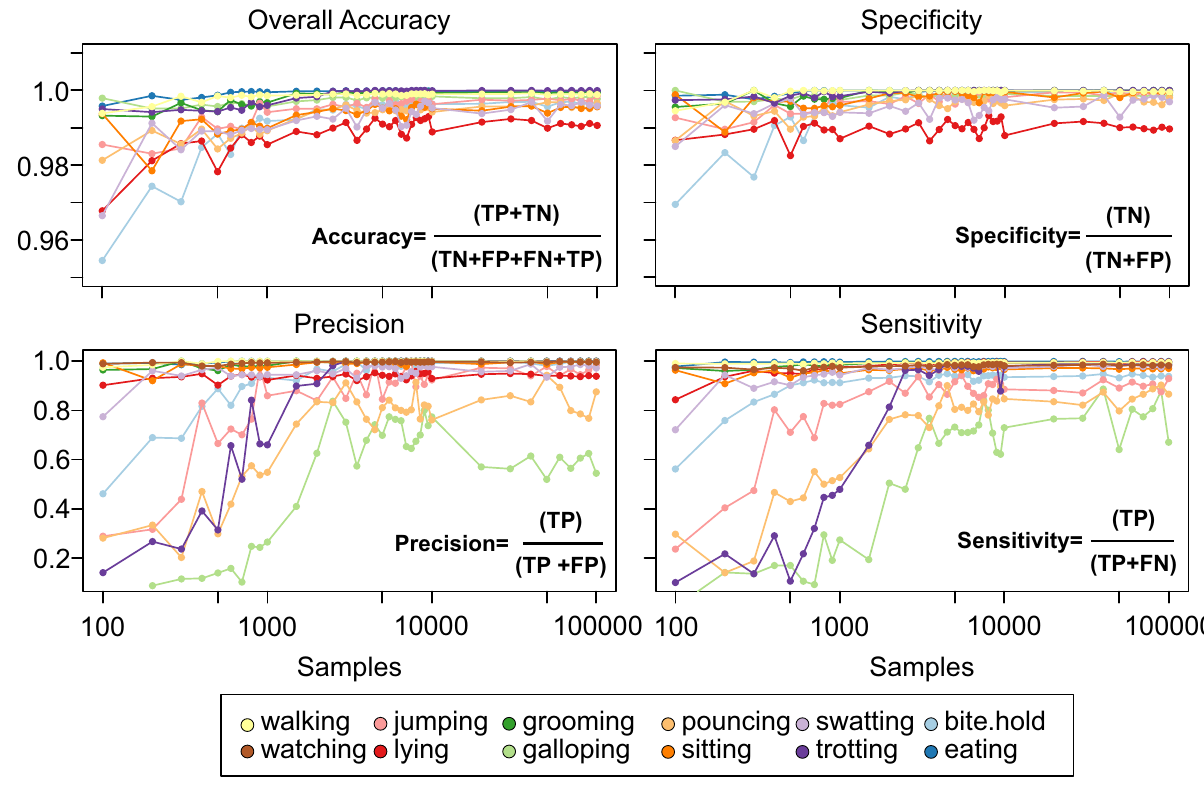
Figure 2. Predictability of the SOM procedure across four behaviour specific metrics. Predicted behaviours were labelled as true positive (TP) if they correctly matched the actual behaviour, true negative (TN) if